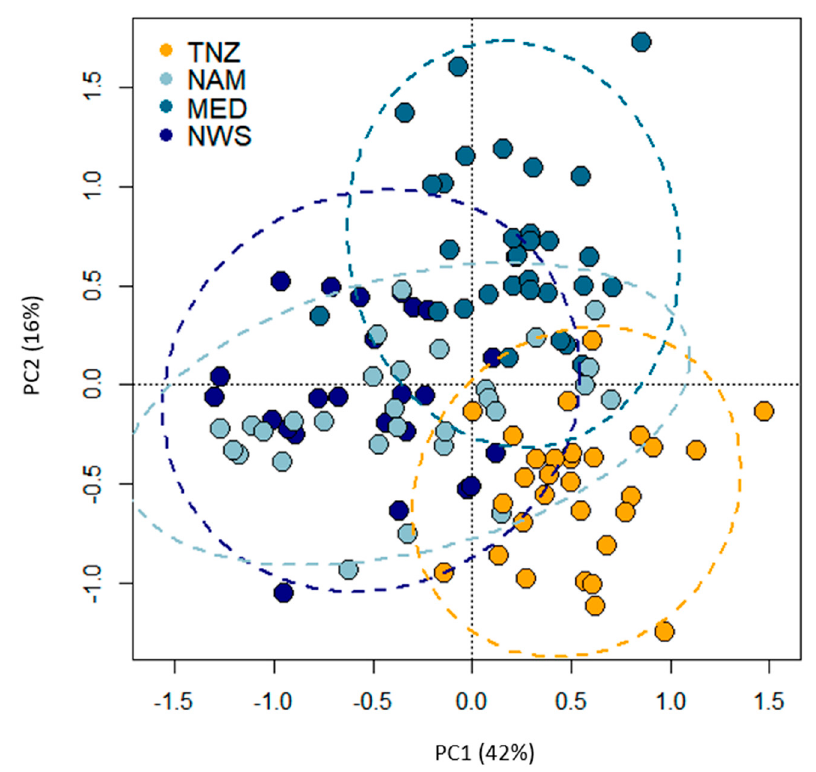
Figure 2. Principal component analysis (PCA) performed on apical view spore measurements of Kudoa mirabilis in Trichiurus lepturus from Tanzanian waters (TNZ = yellow dots), Kudoa thyrsites in Thyrsites atun o ff the coast of Namibia (NAM = light blue dots), K. thyrsites in Lepidopus caudatus from the Mediterranean Sea (MED = turquoise dots), and K. thyrsites in Scomber scombrus from Norwegian Sea (NWS = blue dots). Plots with 95% confidence interval of the standard deviations of the points were generated. PC1 and PC2 explains approximately 42% and 16%, respectively, of the observed variability.